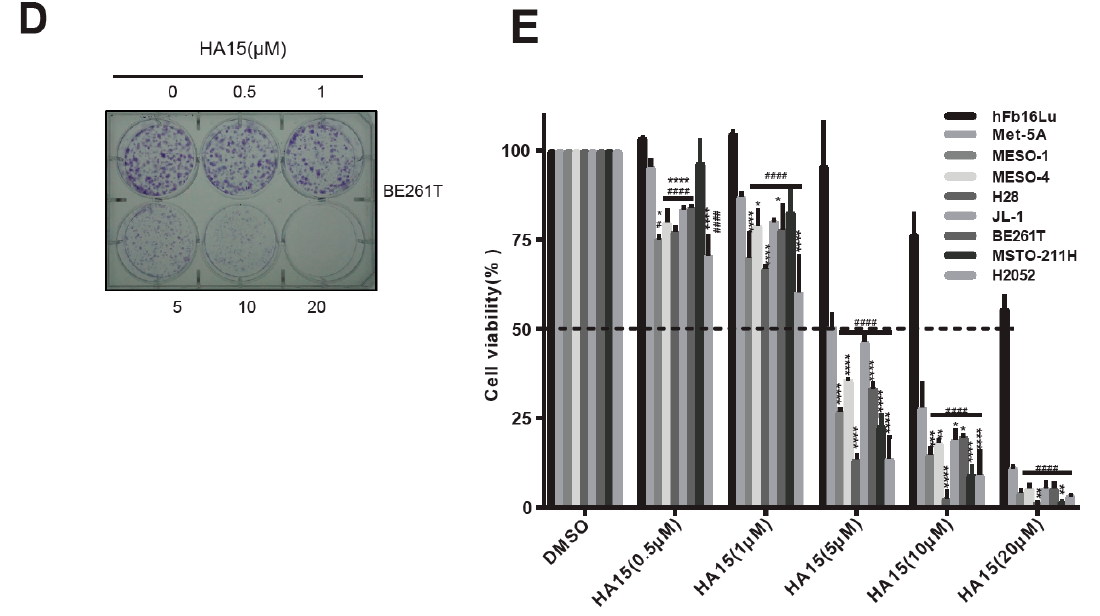
Figure 2. Excess ER stress induced by HA15 selectively inhibits MPM cells. ( A , B ) Cell viability and IC 50 of normal human lung fibroblasts (hFb16Lu), normal human mesothelial (Met-5A), and MPM cells after treatment with HA15 for 72 h. Data are presented as mean ± s.d. A representative result is presented ( n = 2). ( C – E ) Clonogenic assay of MPM cell lines ( C ), primary MPM culture (BE261T) ( D ), normal human lung fibroblasts (hFb16Lu), and normal human mesothelial (Met-5A) after being treated with HA15. Colonies were stained and quantified (right panel) after 14 days. Representative images of three independent experiments ( n = 3) are shown. Quantification ( E ) was based on the results of ( C ) and ( D ). Data are presented as mean ± s.d. ( n = 3). # p < 0.05, #### p < 0.0001 by two-way ANOVA with Dunnett’s multiple comparisons test, when compared with hFb16Lu. * p < 0.05, ** p < 0.01, *** p < 0.005, and **** p < 0.0001 by two-way ANOVA with Dunnett’s multiple comparisons test, when compared with Met-5A.